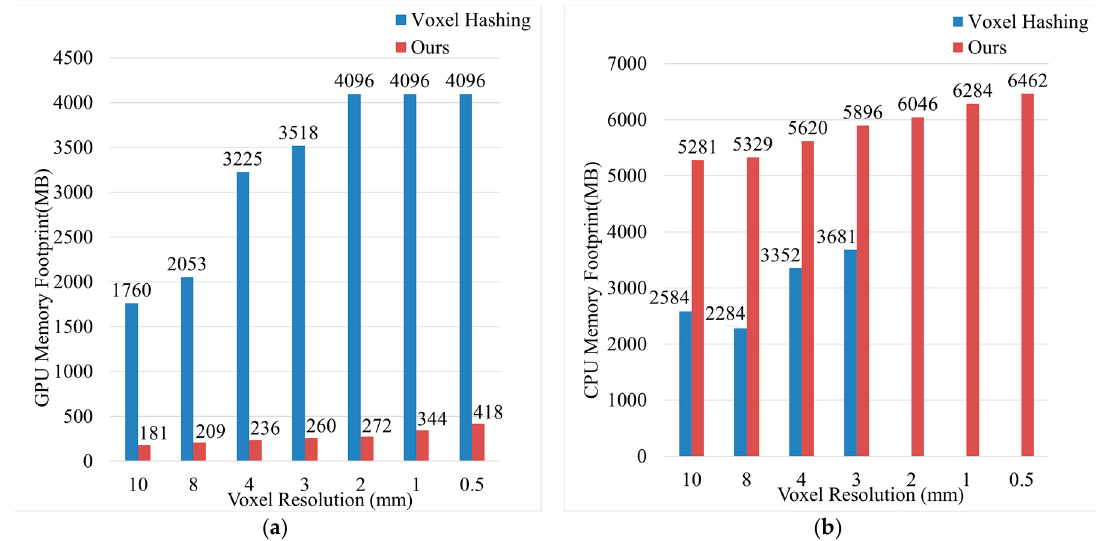
Figure 20. Memory footprint comparisons; ( a ) GPU memory footprint comparisons; ( b ) CPU memory footprint comparisons.